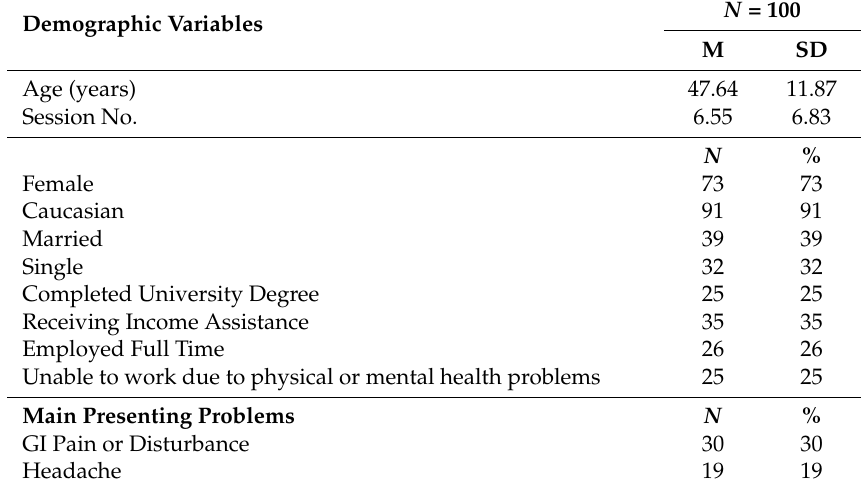
Table 6. Demographic and Baseline Characteristics of Patients seen at least